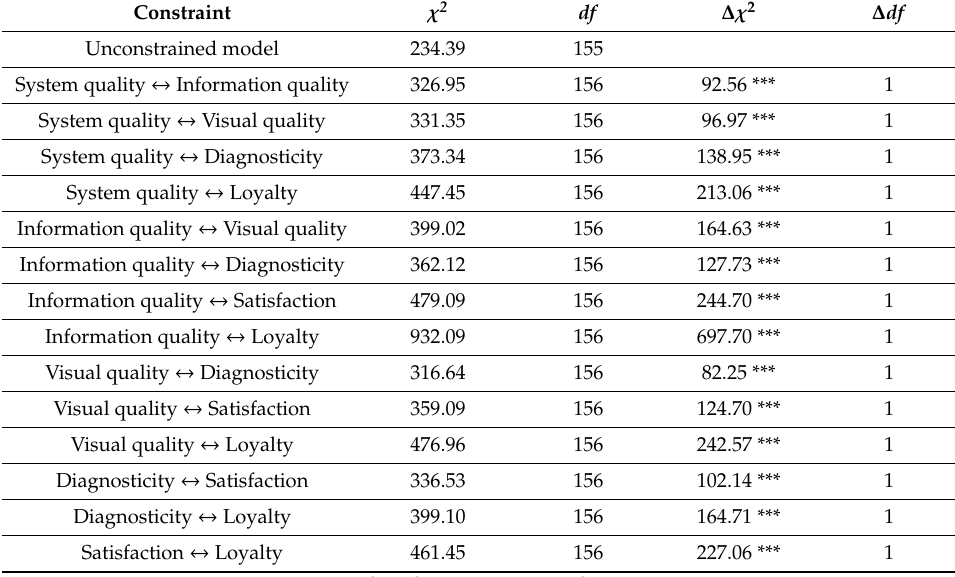
Table 3. Chi-square di ff erence tests for discriminant validity.